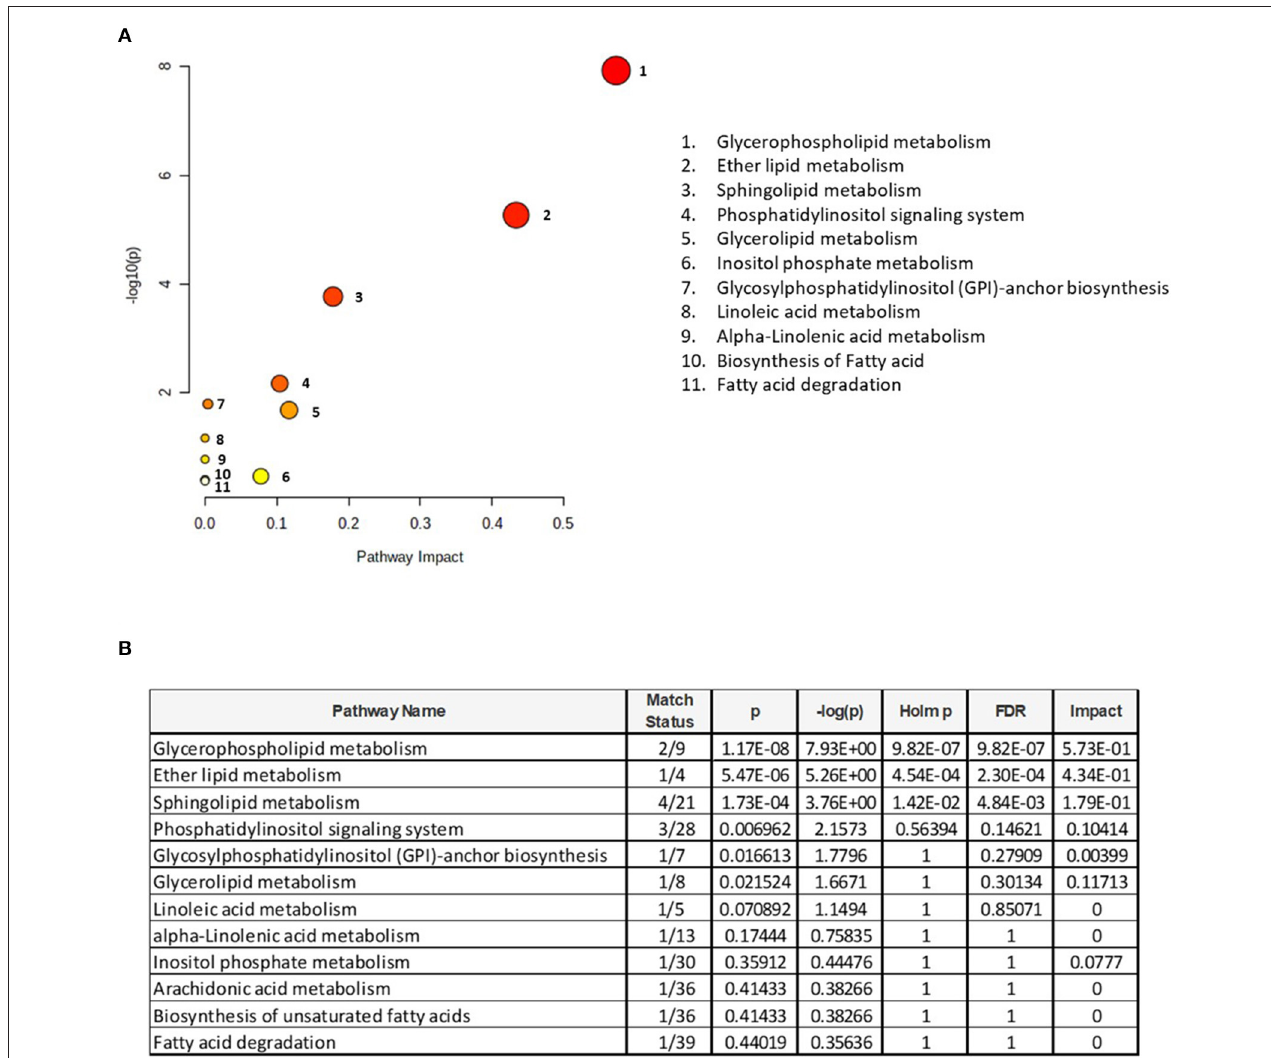
FIGURE 3 | Pathway enrichment analysis. (A) Identification of metabolomic pathways altered by the supplementation and (B) metabolome view with all matched pathways according to the p -values from the pathway enrichment analysis and pathway impact values from the pathway topology analysis are presented. The size of the circle reflects the impact on the pathway, where larger circles denote bigger impacts. The color intensities increase with reducing p -value. Match status is the total number of annotated lipids in the pathway. The raw p is the original p -values calculated from the enrichment analysis. The holm p is the value adjusted by Holm–Bonferroni method. The impact is the pathway impact value calculated from the pathway topology analysis.